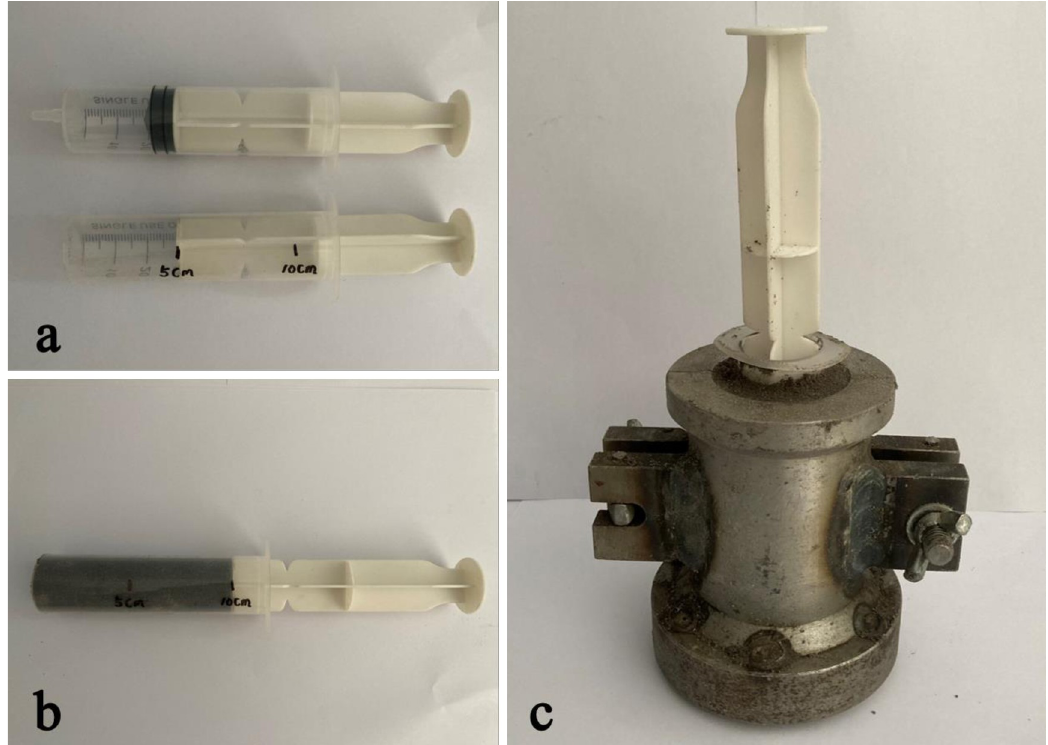
Fig 5. Shaping of specimens with mixed